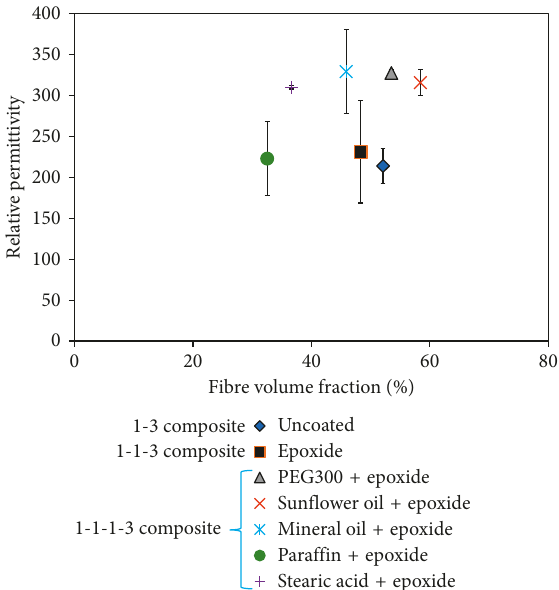
Figure 6: The relative permittivity ( ε T 33 ) of 1–3, 1-1-3, and 1-1-1-3 PZT-based composite discs against the fibre volume fraction based on Equation